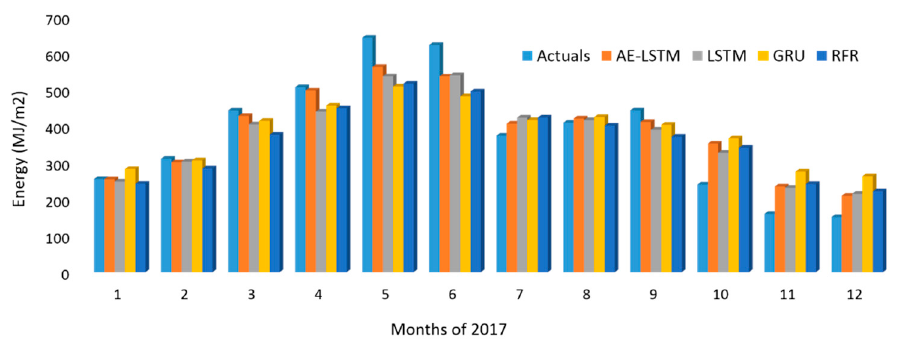
Figure 15. PV energy potential estimation for the year 2017. Energies 2020 , 13 , 4373